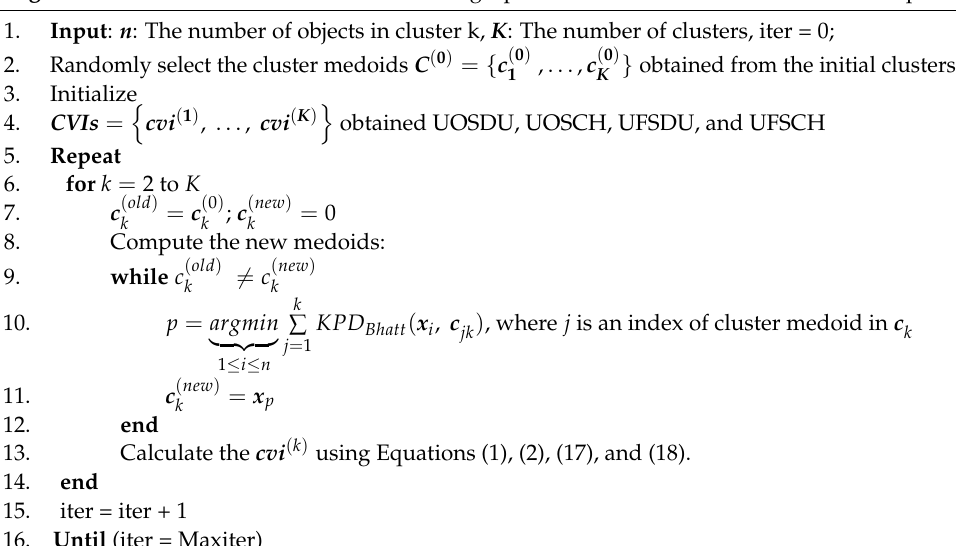
Algorithm 1: K-medoids for uncertain data using a probabilistic distance measure in feature